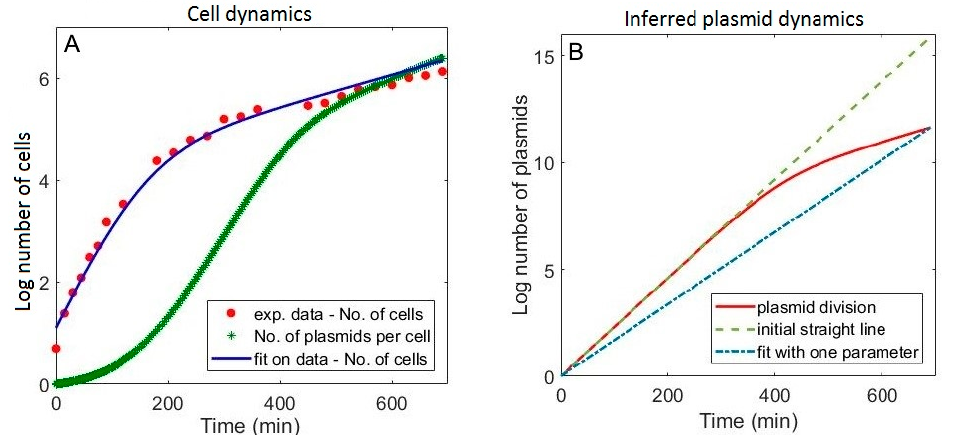
Figure 4. Population (cell and plasmid) dynamics. ( A ) Experimentally measured log number of cells vs. time (red dots) fitted by equation (12) (blue curve). The average number of plasmids per cell in time (green crosses), is shown on the same graph to allow comparison; ( B ) Solid red curve corresponds to the plasmid dynamics from Equation (13), described by three parameters (in analogy to the experimentally observed cell dynamics). Green dashed line represents the plasmid dynamics generated by the constant plasmid division rate, which corresponds to extrapolating the early part of the red curve to the end of the experiment. Blue dash-dotted line also corresponds to the assumption of constant plasmid division rate, where the division rate is taken as a free parameter obtained by fitting the model to R and M dynamics data.